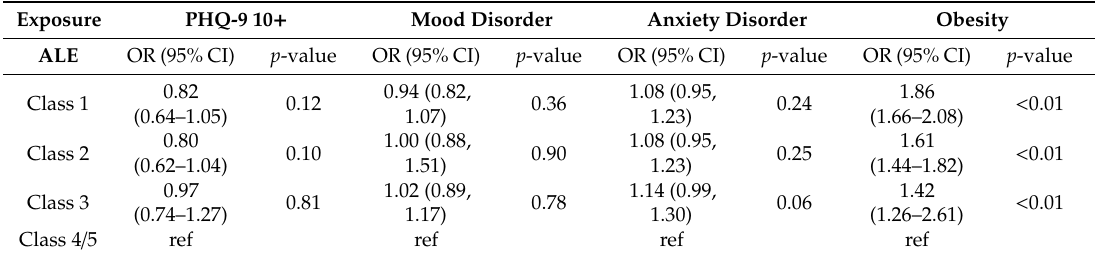
Table 2. Crude models of mental health outcomes and